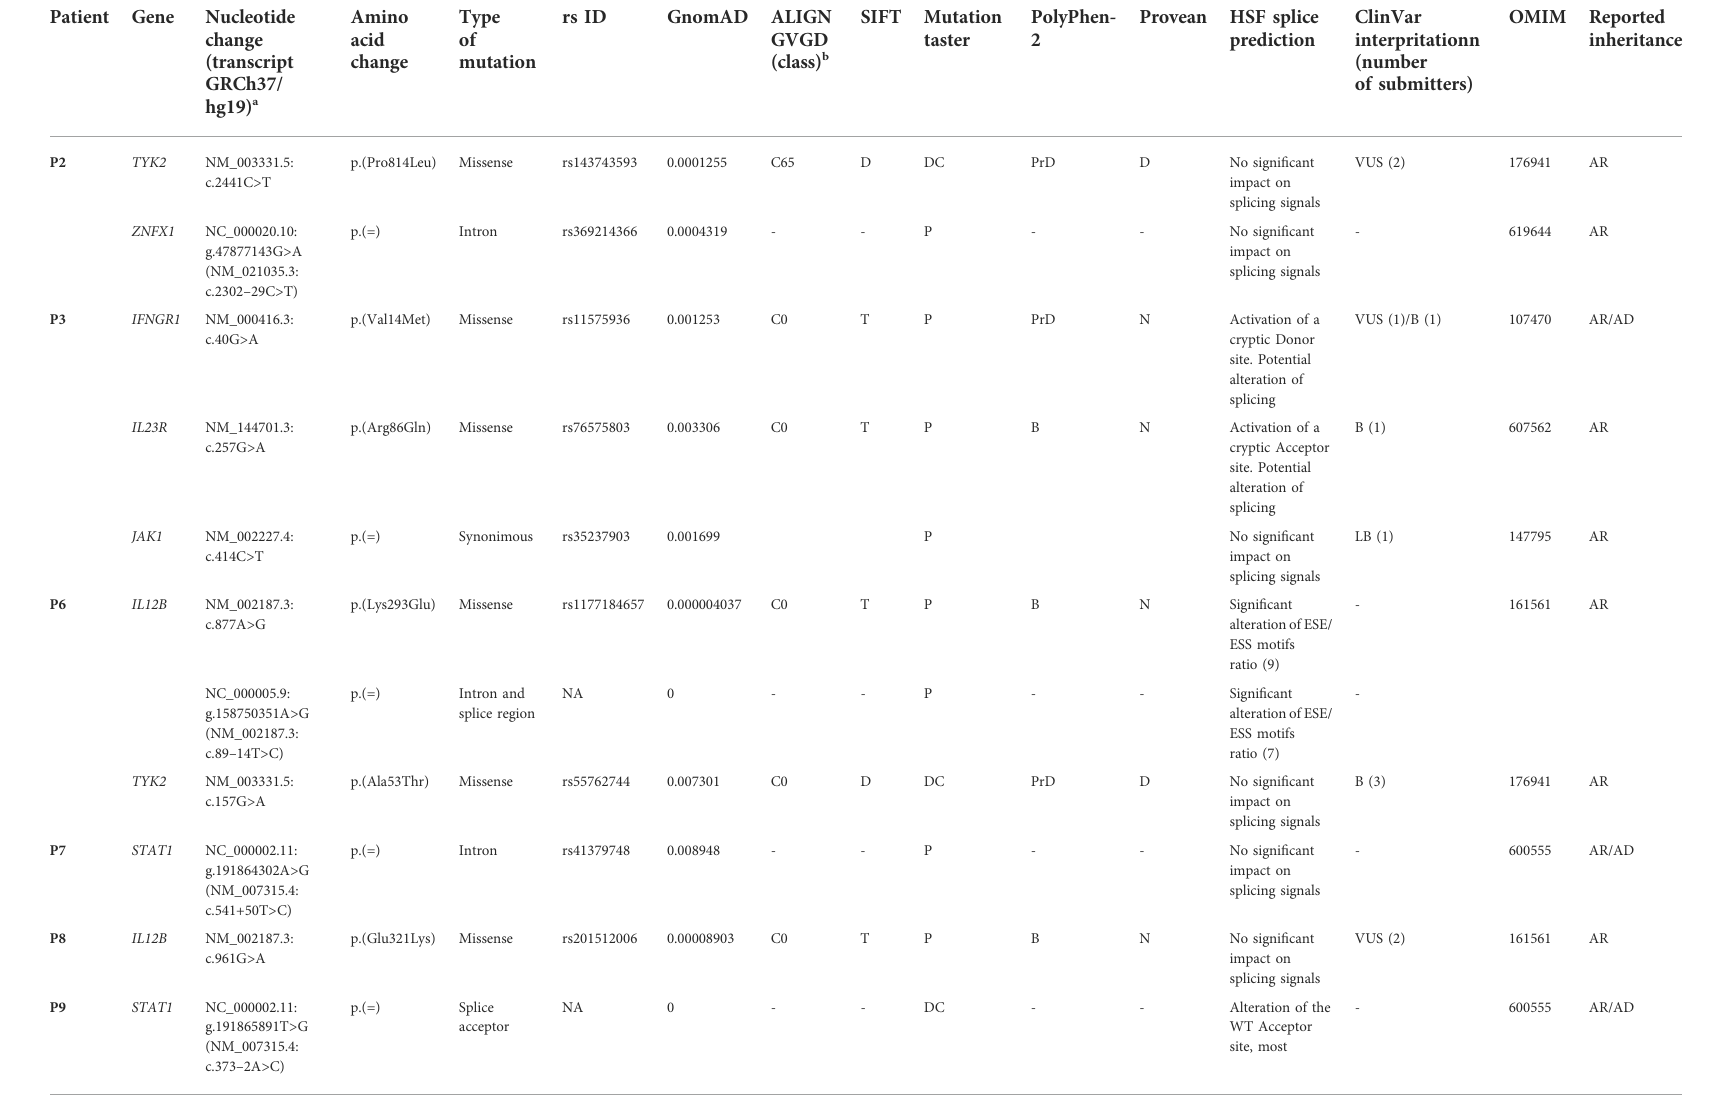
TABLE 2 Rare variants (MAF < 0.01) identi fi ed in the known MSMD-associated genes. Patient